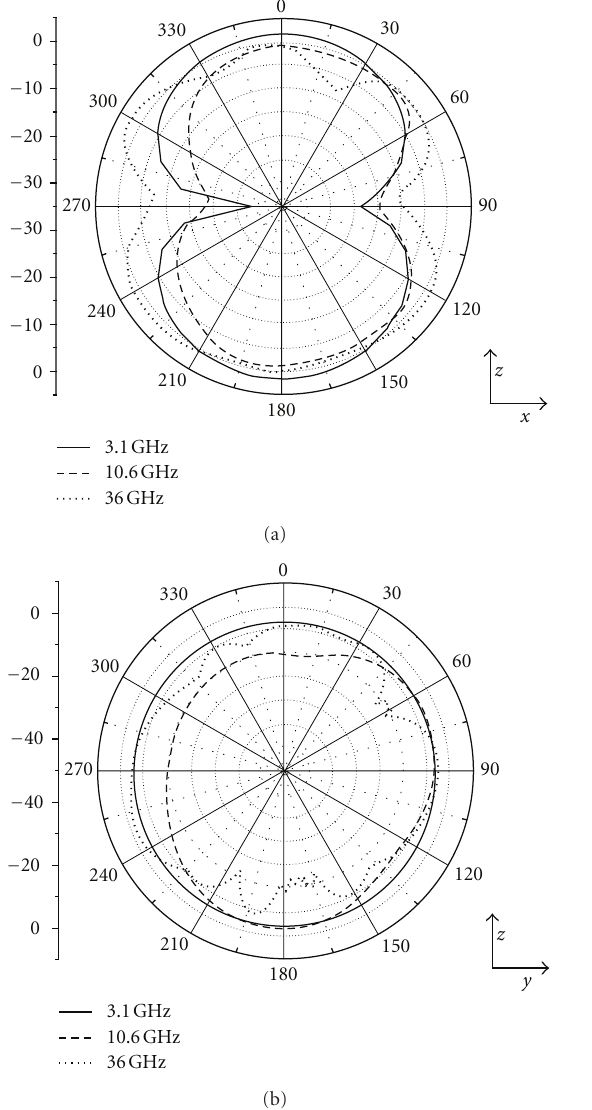
Figure 9: Radiation patterns on E -plane ( x-z plane) and H -plane ( y-z plane) for the dual band-notched antenna 2 at 3.1 GHz, 10.6 GHz, and 36 GHz: (a) E -plane (b) H